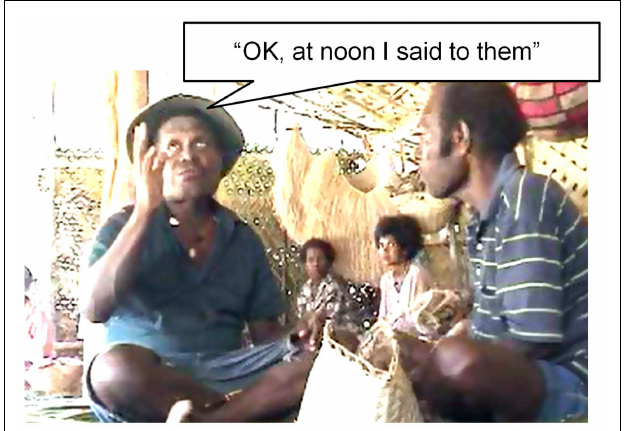
FIGURE 5 |Time pointing with the eyes and hand, indicating the location of the sun.